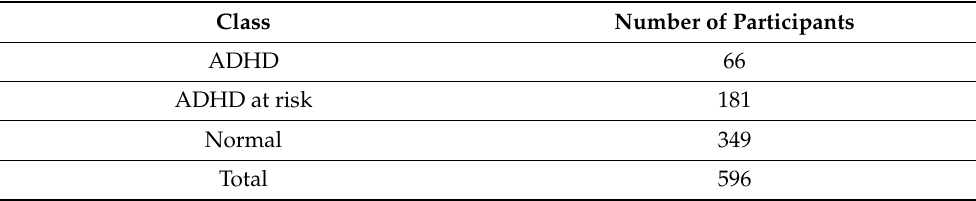
Table 2. Total number of children who participated in this study and the number of children in each class. Class Number of Participants ADHD 66 ADHD at risk 181